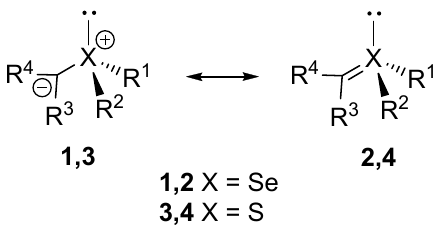
Figure 3. Stereo presentation of resonance structures of selenium(sulfur) ylides 1 – 4 .